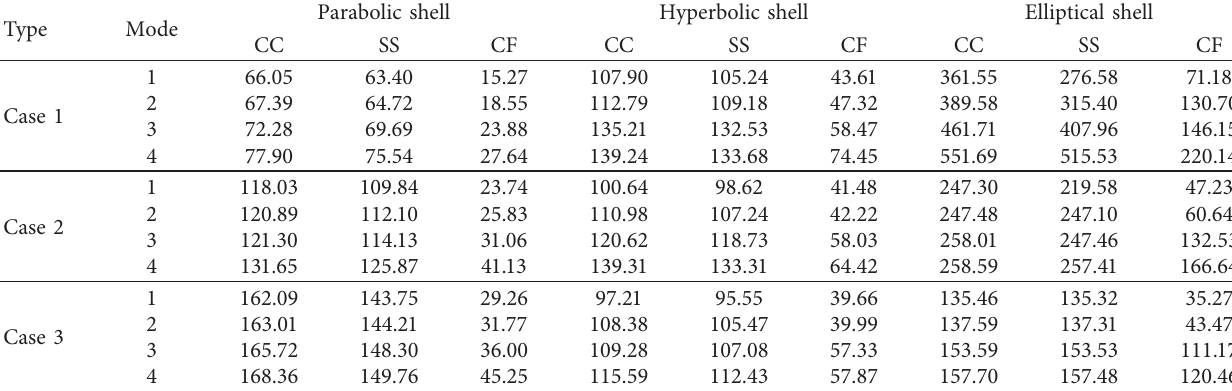
Table 6: First four frequencies for Type 1-1 Sandwich FGP doubly curved structure with diverse boundary conditions. Type